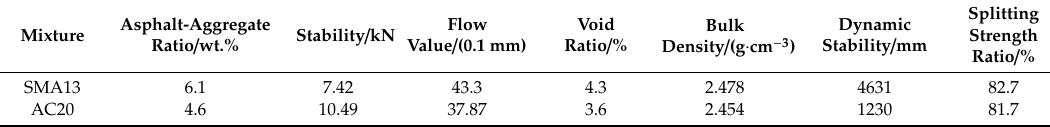
Figure 2. Aggregate grading curves of the AC20 asphalt mixture. Table 3. Volumetric parameters and performance test results of SMA13 and AC20.